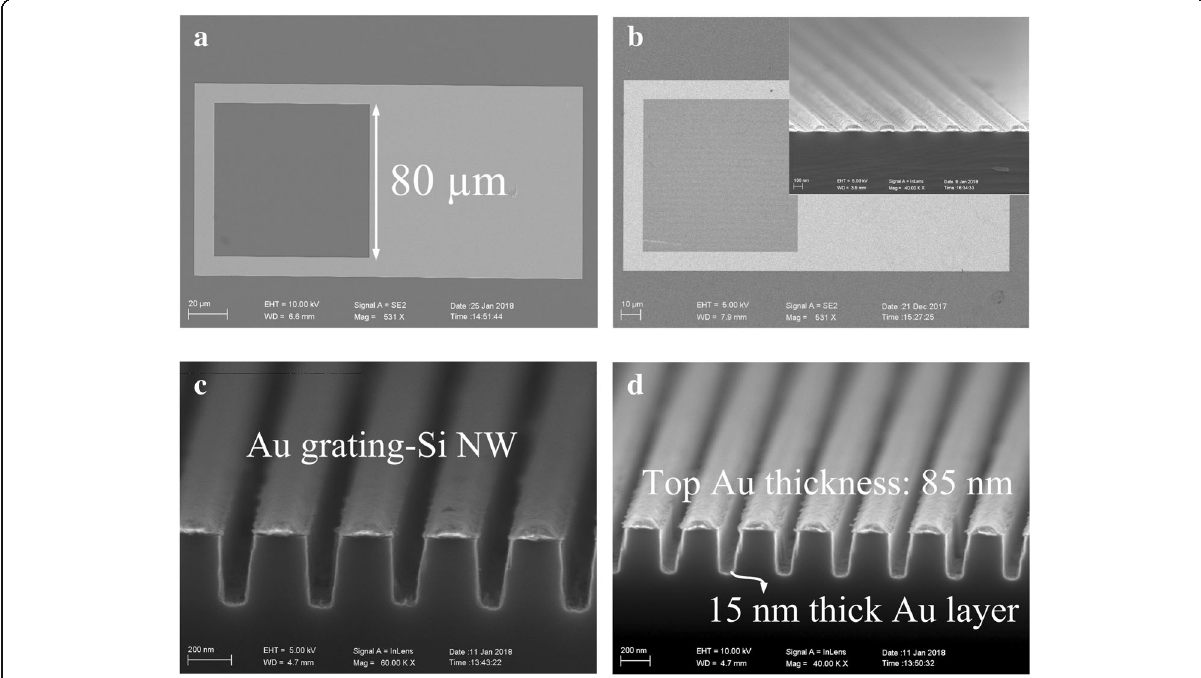
Fig. 4 Micrographs by scanning electron microscope (SEM) for the fabricated MS photo-electron detectors. a Str.1: the overview of the device with the bonding pad only. b Str.2: the Au grating-planar Si located inside the square window. c Str.3: the cross-sectional view of Au grating-Si NW device. d Str.4: the cross-sectional view of the finally fabricated device with resonant